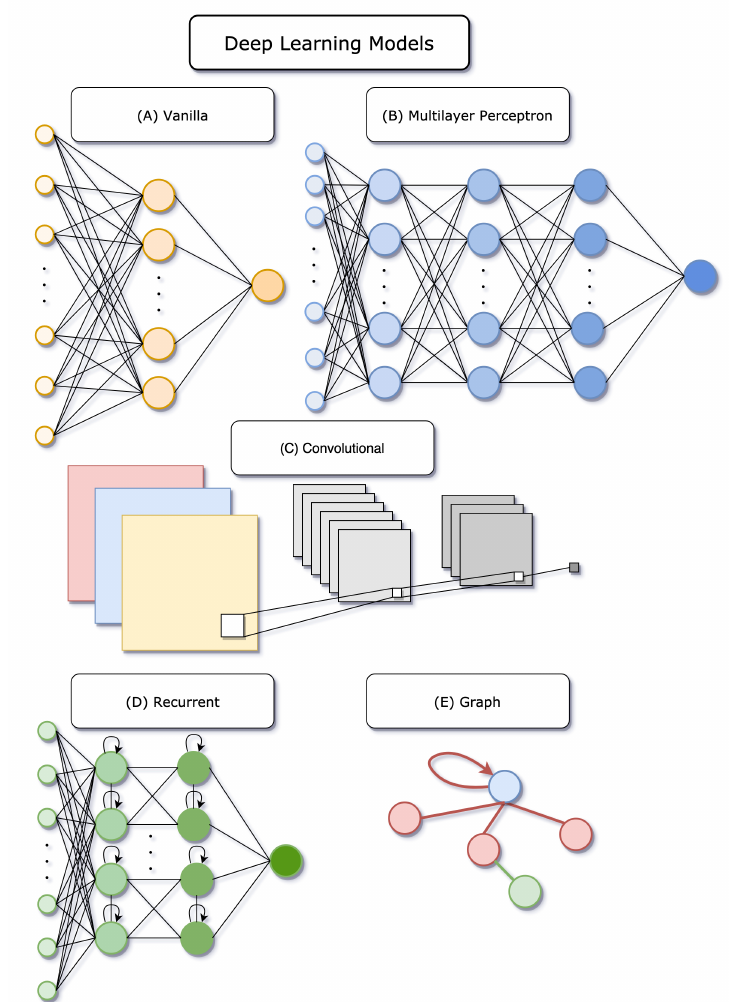
Figure 4. Deep learning models. Schematic illustration of the neural networks described in Section 2.2. ( A ) Vanilla neural network. ( B ) Multilayer perceptron with three hidden layers (MLP). ( C ) Convolutional neural network (CNN). ( D ) Recurrent neural network (RNN). ( E ) Graph neural network (GNN). CNNs and GNNs particularly have become very popular in recent virtual screening studies (see tables in Section